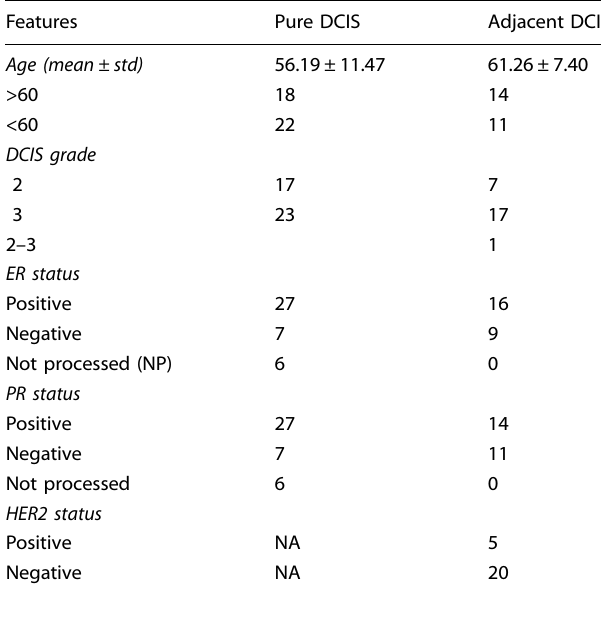
Table 2. Demographics of patients belonging to DUKE dataset comprising pure DCIS and adjacent